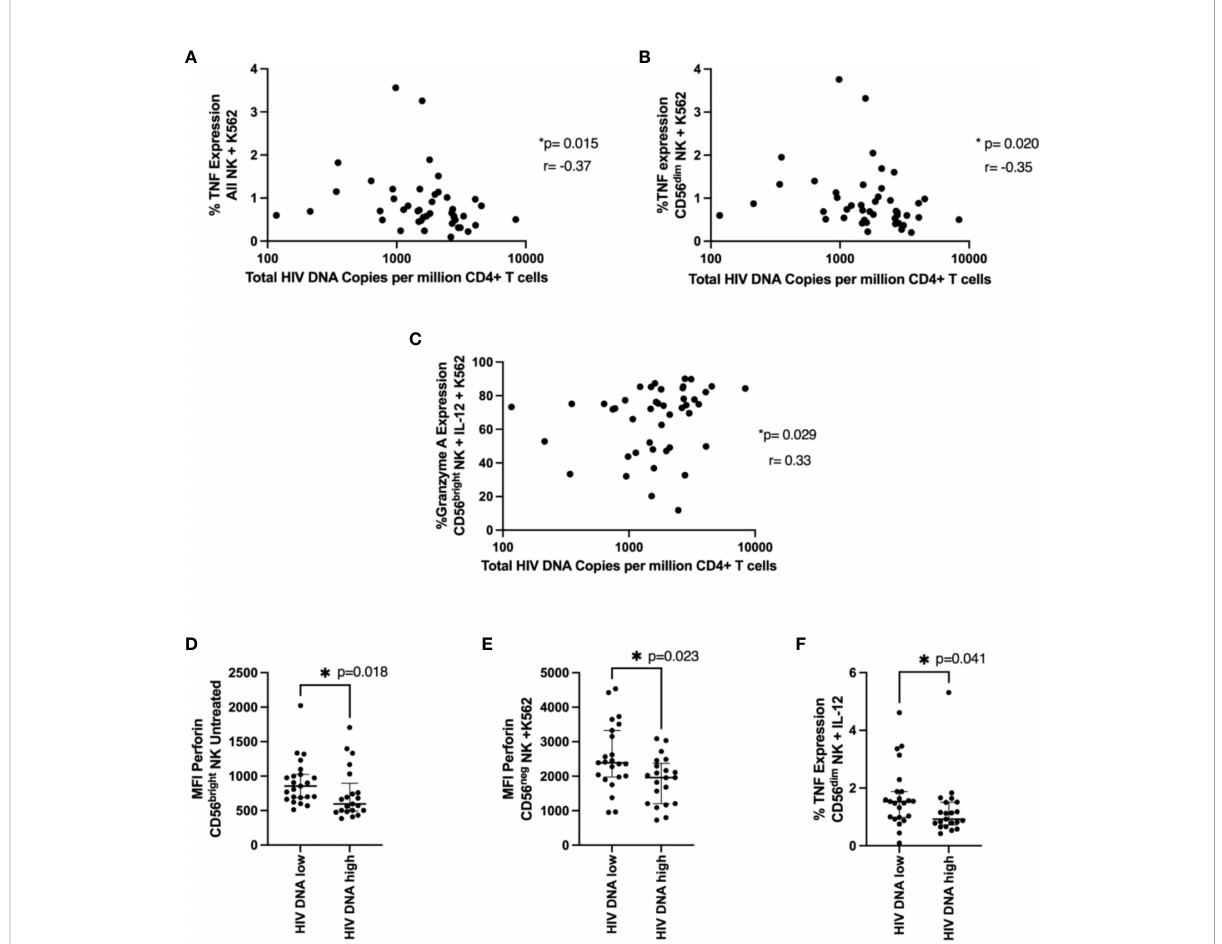
FIGURE 5 NK cell function and total HIV DNA levels. Cells were treated and stained as in Figure 4. In (A, B), a correlation between TNF expression in NK cells (A) or in CD56 dim NK cells (B) co-cultured with K562 cells and total HIV DNA at 48 weeks post ART is shown. A Spearman test was used and p and r values are shown. In (C – F) a Mann-Whitney test was performed between individuals with < or ≥ median HIV DNA levels for the MFI of perforin in untreated CD56 bright NK cells (C) , the MFI of perforin in CD56 neg NK cells co-cultured with K562 cells (D) and the percent TNF expression of CD56 dim NK cells treated with IL-12 and IL-18 (E) . *P <